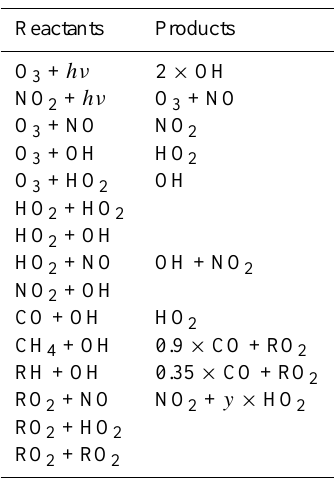
Table 1. Reactions included in the model. Reaction rate coefficients are the ones described in Huijnen et al. (2010), except for photolysis rates, which are computed using